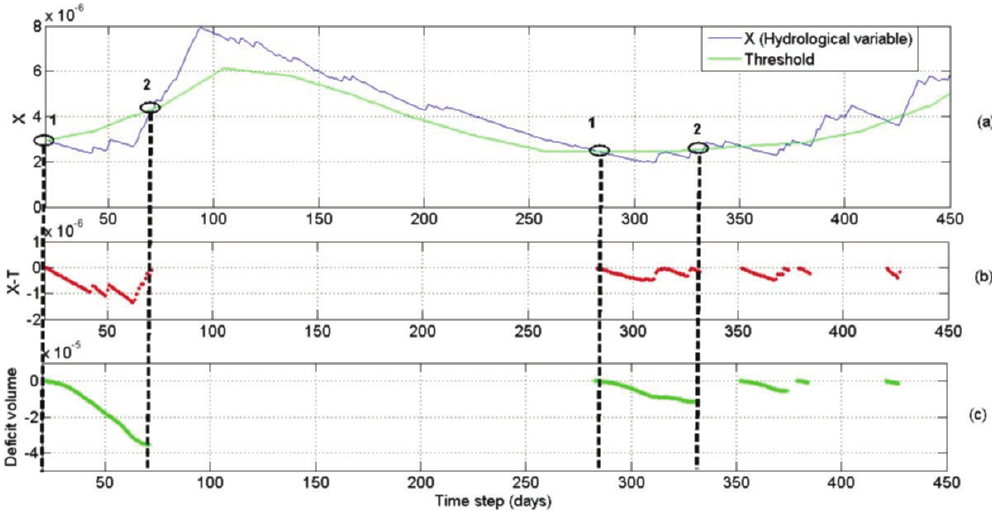
Fig. 2. Diagram of temporal and spatial analysis interaction.